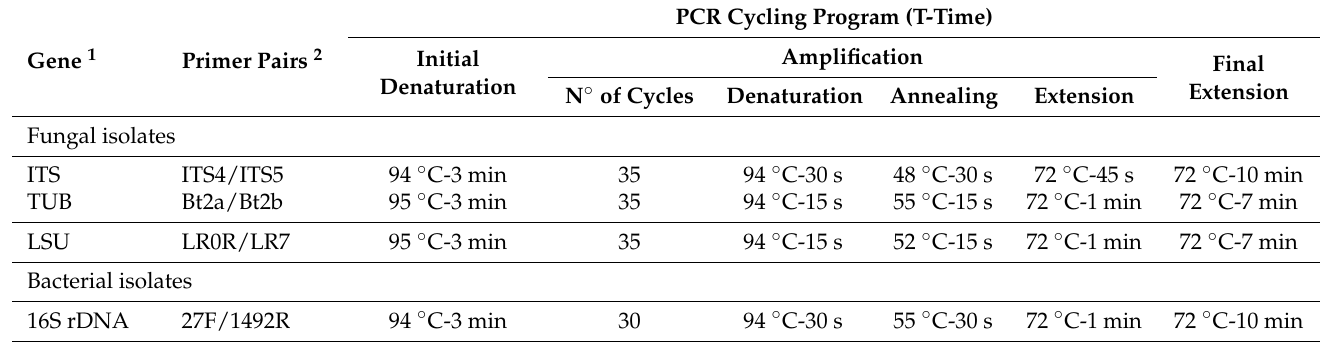
Table 1. Primer pairs and PCR conditions used for the amplification of the genes included in this